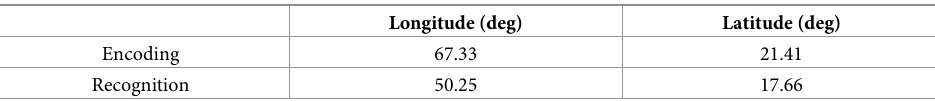
Table 1. Spreads (median standard deviations) of eye